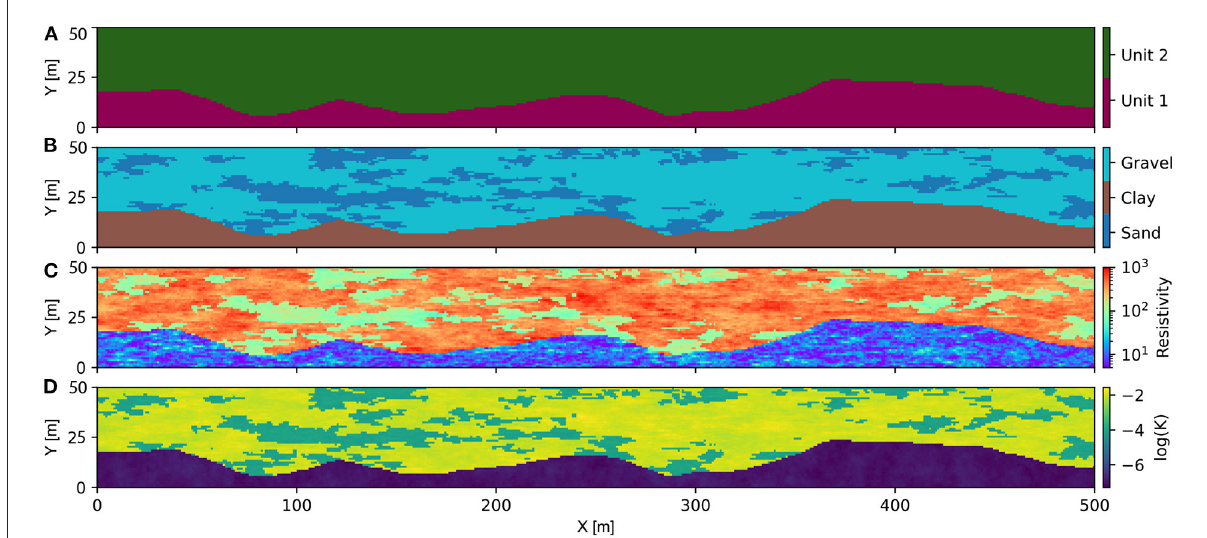
FIGURE1 Two dimensional example of an ArchPy simulation with the three simulation steps. (A) Simulation of units. (B) Simulation of facies. (C) simulation of the resistivity field. (D) Simulation of the permeability